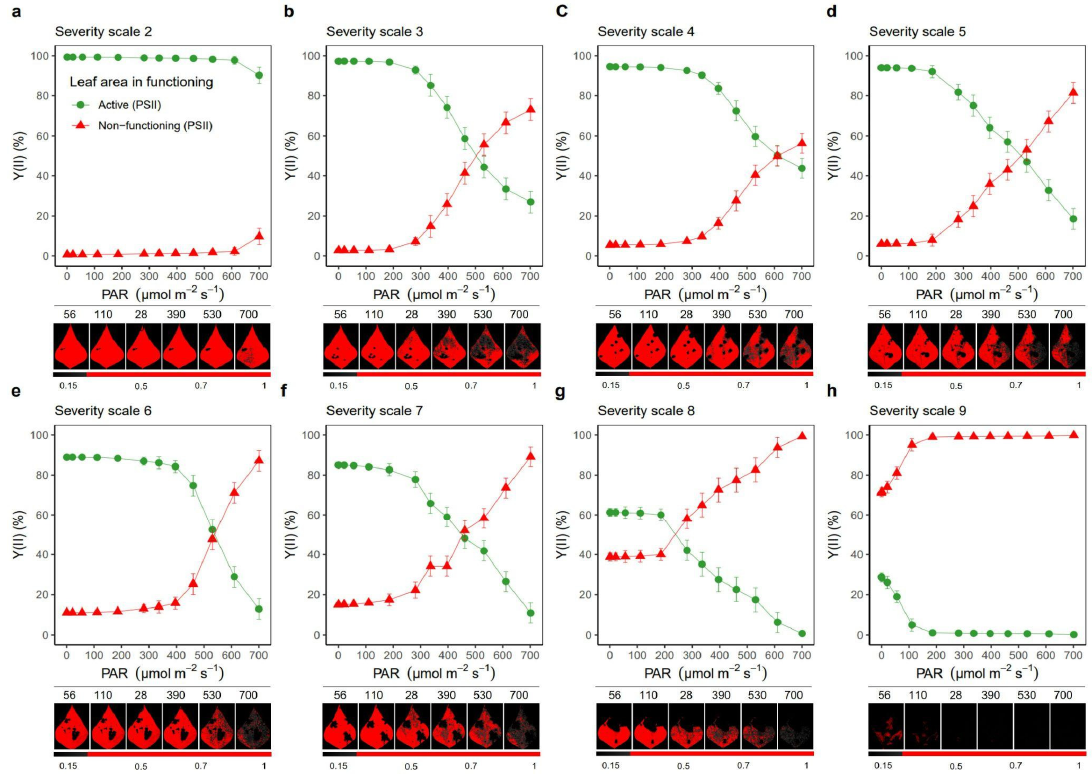
Figure 6. Effect of the pathogen on leaf area and photosynthetic apparatus functioning in relation to the